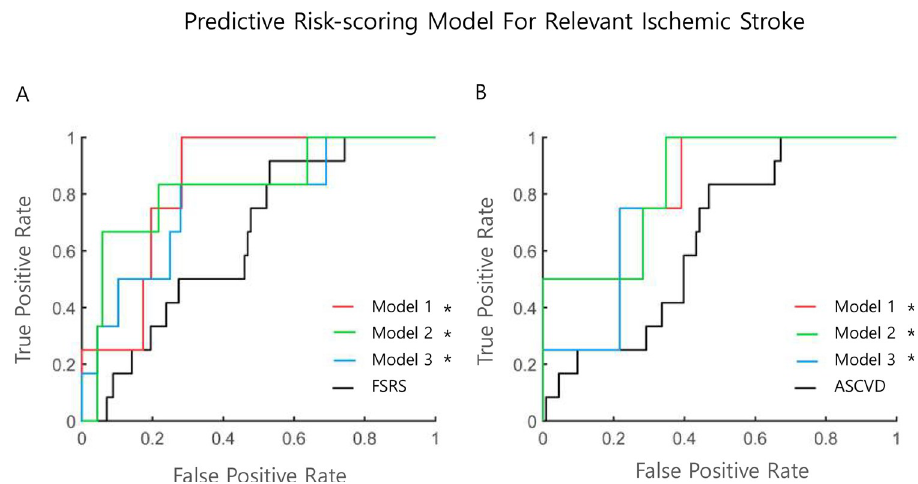
Fig 1. Comparison of ROC curves of novel risk prediction models for relevant ischemic stroke. A. Different models based on the FSRS for prediction of relevant ischemic stroke. ROC curves in the FSRS (black line), Model 1 (FSRS, PSV, CIMT, high-risk plaque, and PI, red line), Model 2 (FSRS, PSV ratio, CIMT, high-risk plaque, and PI, green line), and Model 3 (FSRS, PSV/EDV ratio, CIMT, high-risk plaque, and PI, blue line) are shown. B. Different models based on the ASCVD risk score for prediction of relevant ischemic stroke. ROC curves in ASCVD risk score (black line), Model 1 (ASCVD, PSV, CIMT, high-risk plaque, and PI, red line), Model 2 (ASCVD, PSV/EDV ratio, CIMT, high-risk plaque, and PI, green line), and Model 3 (ASCVD, PSV ratio, CIMT, high-risk plaque, and PI, blue line) are shown. Abbreviations: ROC, receiver operating characteristics; FSRS, Framingham stroke risk score; PSV, peak-systolic velocity; CIMT, common carotid artery intima-media thickness; PI, pulsatility index; PSV/EDV ratio, peak-systolic- and-end-diastolic-velocity-ratio; ASCVD, atherosclerotic cardiovascular disease. � indicates statistically significant (p < 0.05) differences relative to classical cardiovascular risk scores (black